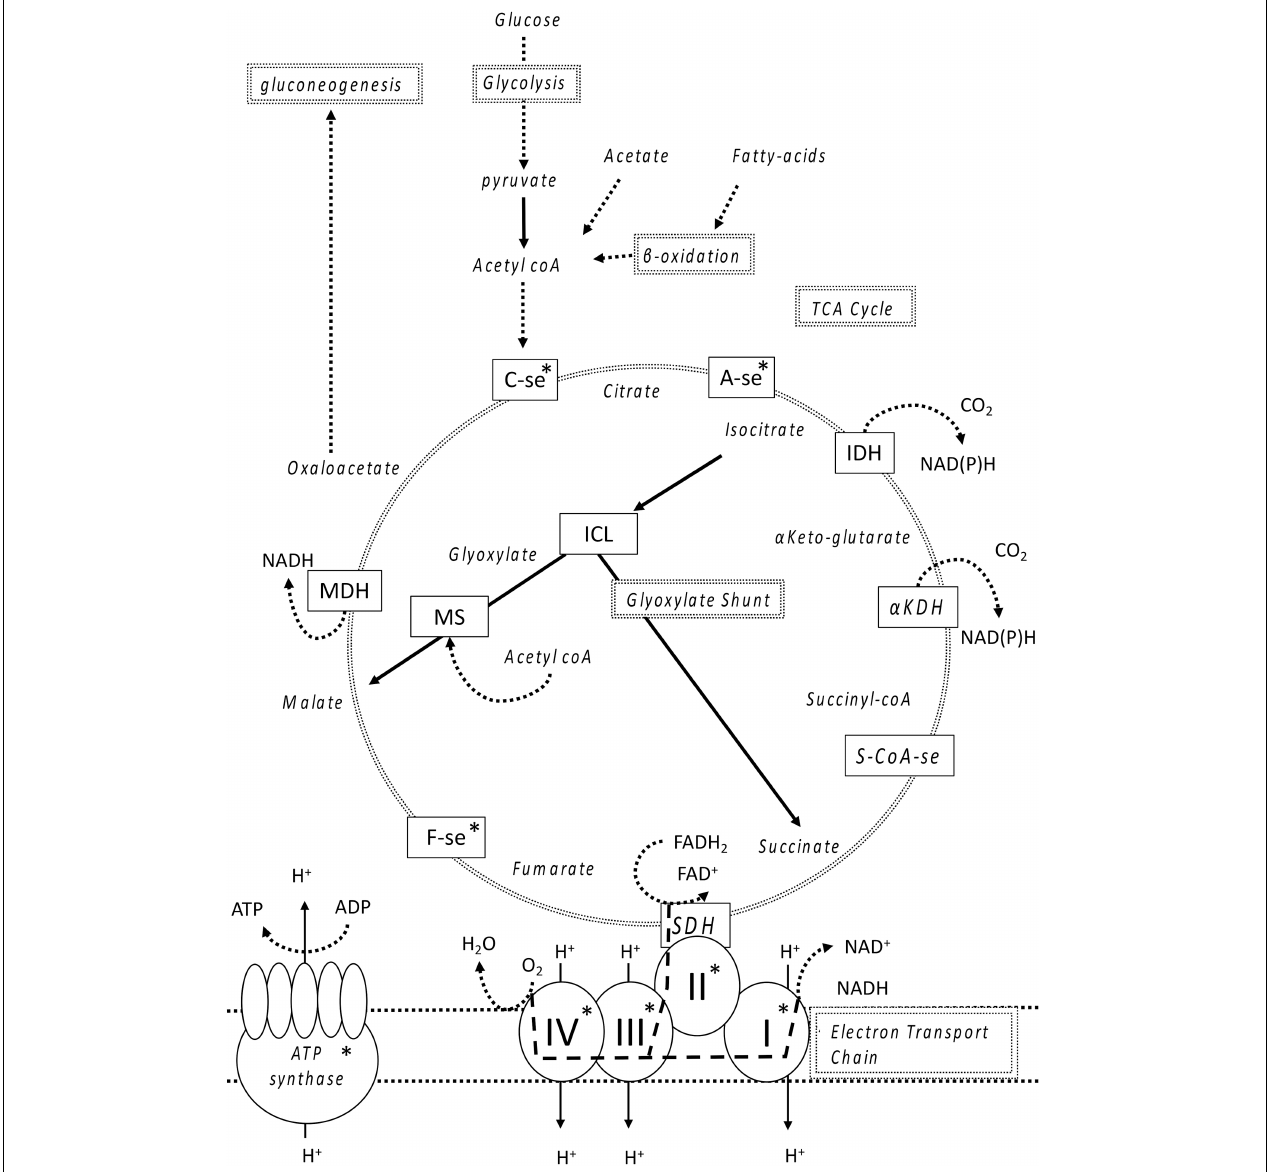
FIGURE 1 | Simplified overview of the TCA cycle and electron transport chain. Double lined boxes indicate the major components of metabolism, single lined boxes are the enzymes utilized and indented text are molecules and metabolites produced by those enzymes. Briefly, glucose undergoes glycolysis for the formation of pyruvate which is converted to acetyl coA that, together with oxaloacetate enters the TCA cycle through the formation of citrate. Acetate and fatty acids are converted to acetyl coA but the biosynthesis of carbohydrates (using malate and oxaloacetate) can only occur upon entering the glyoxylate shunt (dark straight lines) allowing the formation of oxaloacetate, which can then undergo gluconeogenesis, as the pathway from pyruvate to acetyl coA is irreversible. The glyoxylate shunt bypasses the production of CO 2 further down the TCA cycle forming both succinate and malate. Electrons from either NADH or FADH 2 , respectively, enter the electron transport chain either through complex I or II (large dashed lines) resulting in different possible quantities of ATP produced. Take note that SDH and Complex II are the same molecule. Fe-containing enzymes within the TCA-cycle and electron transport chain are marked with an asterisk. The following abbreviations were used for each enzyme: C-se, citrate synthase; A-se, aconitase; IDH, isocitrate dehydrogenase; ICL, isocitrate-lyase; α KDH, alpha keto dehydrogenase; S-coA-se, succinyl coA synthase; SDH, succinate dehydrogenase; F-se, Fumarase; MS, malate synthase; MDH, malate dehydrogenase; Q, quinone, and the roman numerals I, II, III, IV, indicate the four complexes of the electron-transport